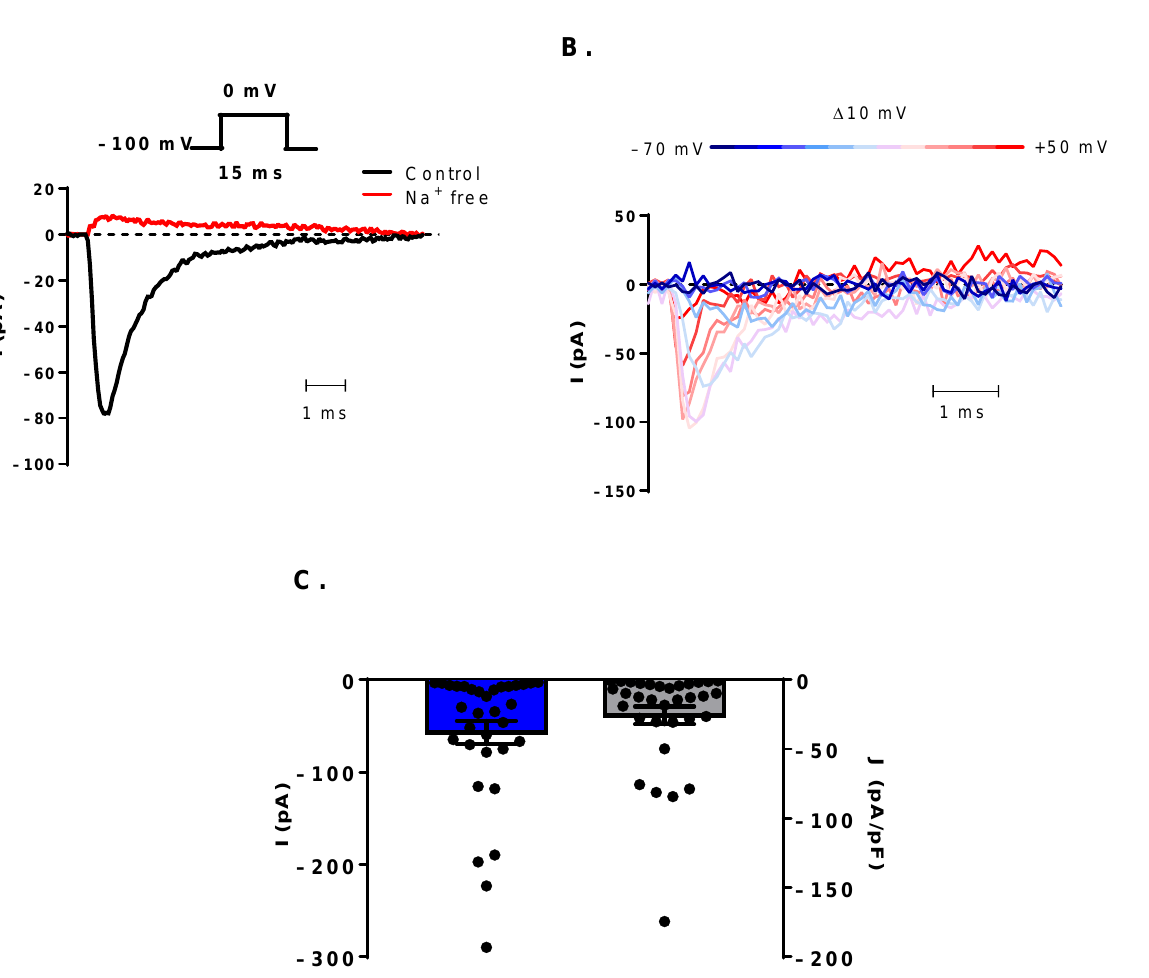
Figure 1. Voltage-gated sodium currents are present in human B lymphocytes. ( A ) An inward current evoked by a depolarizing step from − 100 mV to 0 mV. Black line is for the current recorded in control solution, while red trace represents the current recorded in Na + -free solution. ( B ) The voltage-dependence of the current is shown from − 70 to +50 mV in + 10 mV increments. The negative clamped potentials are in the shades of blue, and the positive ones are in the shades of red. ( C ) Summary of the peak current (blue bar, left Y-axis) and current density (gray bar, right Y-axis) values obtained at 0 mV depolarizations. Bar heights indicate mean ± SEM.